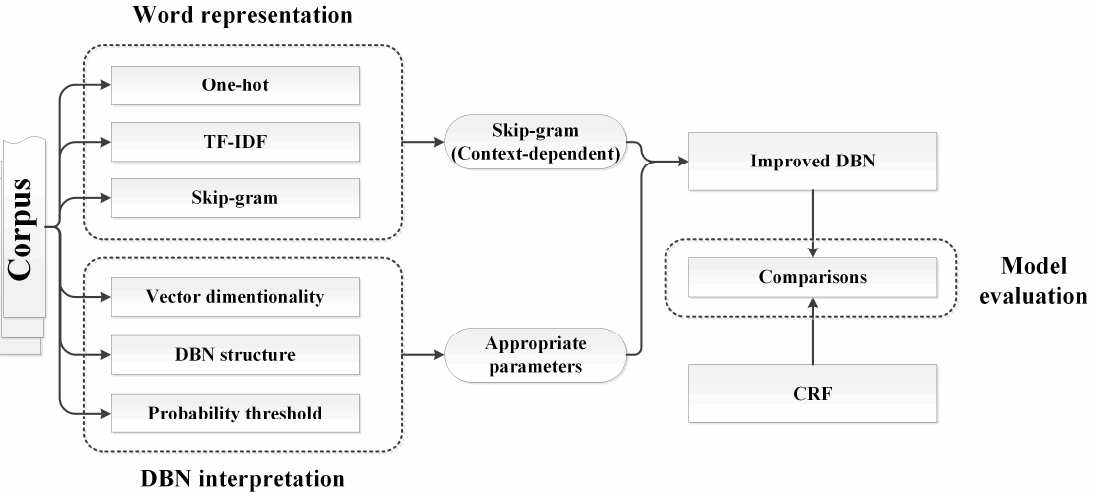
Figure 5. The experimental framework.